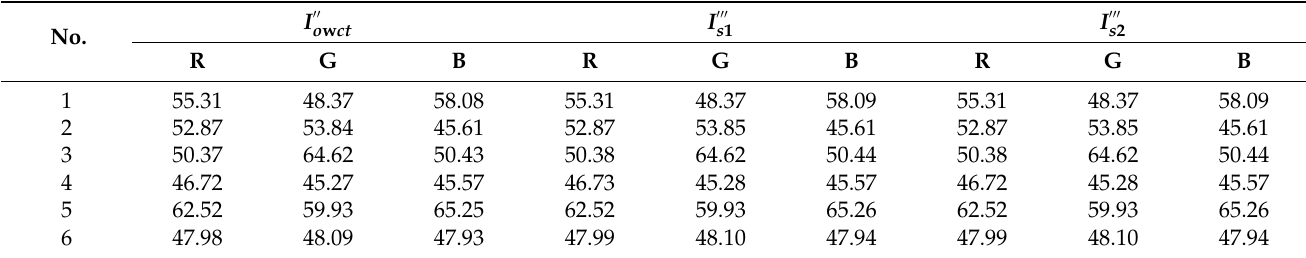
Table 13. The standard deviation of the six test images in three chromatic channels.